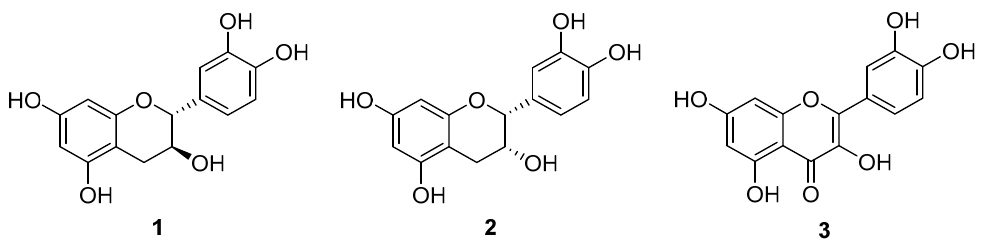
Figure 2. Chemical structures of the flavonoids (+)-catechin ( 1 ), ( − )-epicatechin ( 2 ) and quercetin ( 3 ). Table 2. Examples of flavonoid content extracted from the pomace of various grape types using SLE method; dw = dry weight.